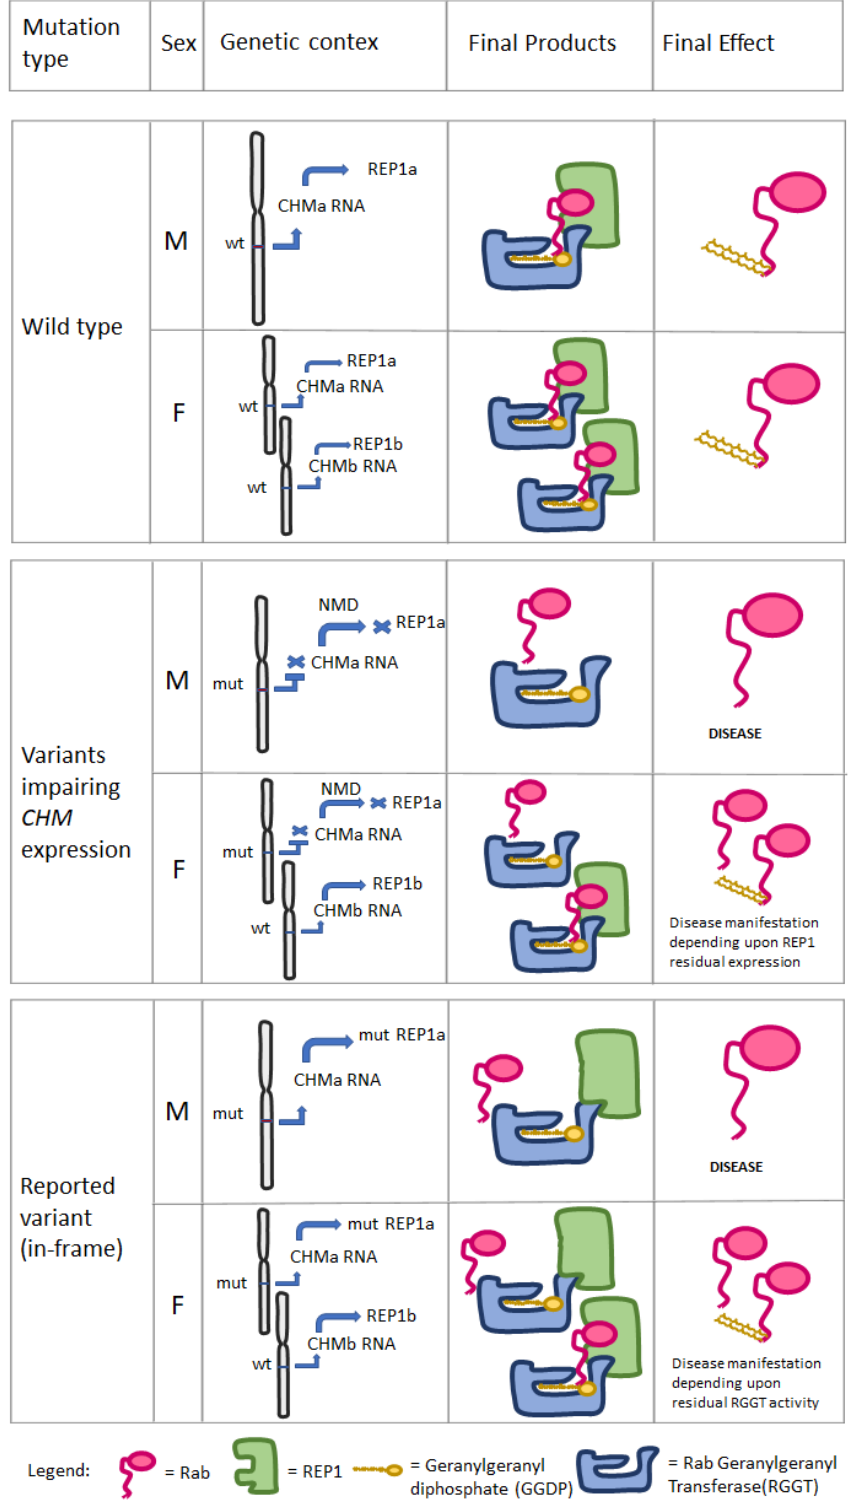
Figure 7. Proposed pathogenic molecular mechanisms for Choroideremia considering CHM biallelic (“a” allele and “b” allele) expression in females, following the alternative model (see Figure 1). The level of REP1a and REP1b expression would depend upon CHM a/ CHM b position on Xa or Xi and the levels of expression of CHM allele from Xi. Legend: wt = wild type allele, mut = mutant allele, NMD= Nonsense RNA Mediated